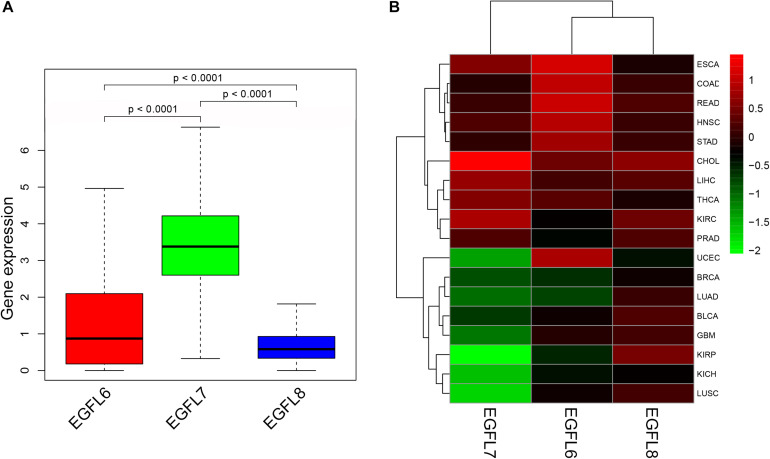
Expression levels of EGFL6/7/8 in cancerous and adjacent normal tissues. (A) Boxplot showing the distribution of EGFL6/7/8 gene expression across all 33 cancer types. (B) Heatmap showing the difference of EGFL6/7/8 gene expression in comparison to the primary tumor to the adjacent normal tissues based on log2 (fold change) for 18 cancer types that have more than five adjacent normal samples.